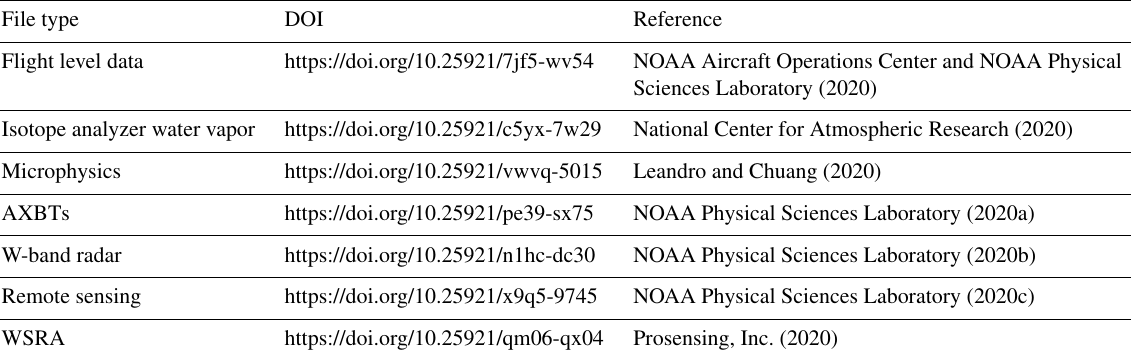
Table 4. Data described in this paper and archived at NOAA’s National Center for Environmental Information. The contents of each file are summarized in Table 3; document object identifiers (DOIs) point to netCDF files following Climate and Forecast